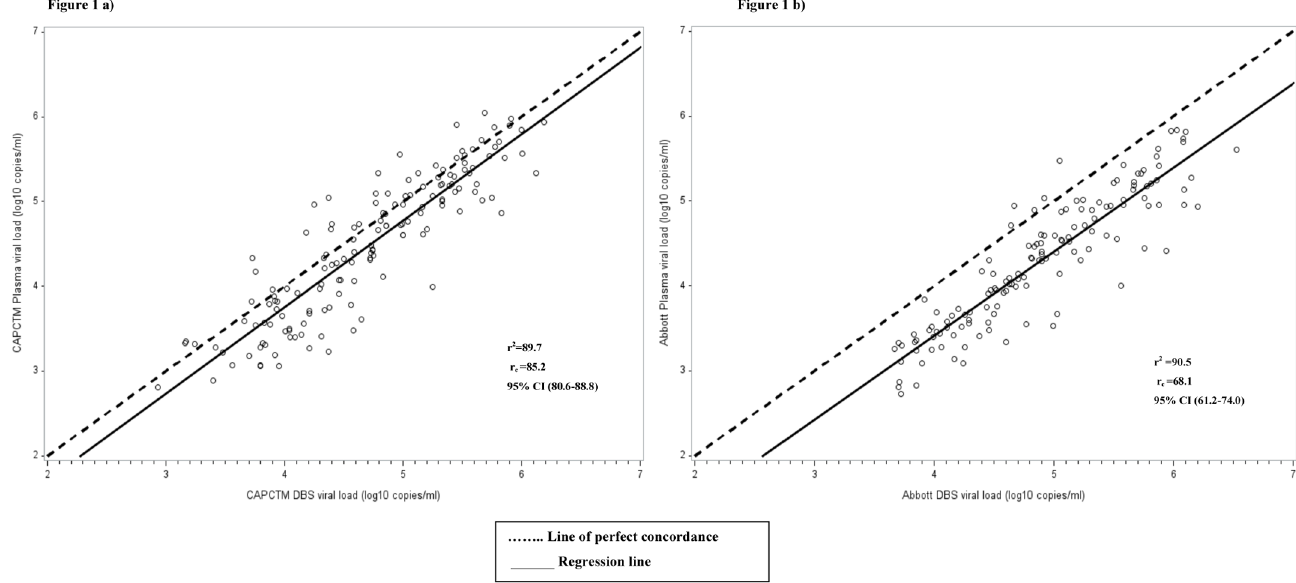
Fig 1. Concordance correlation analysesof HIV-1 (VL) quantification among plasma and DBS specimens collected from patients visiting Nyanza patient support centers and tested with CAP/CTM and Abbott. a) CAP/CTM plasma vs. DBS VL; b ) Abbott plasma vs. DBS VL.